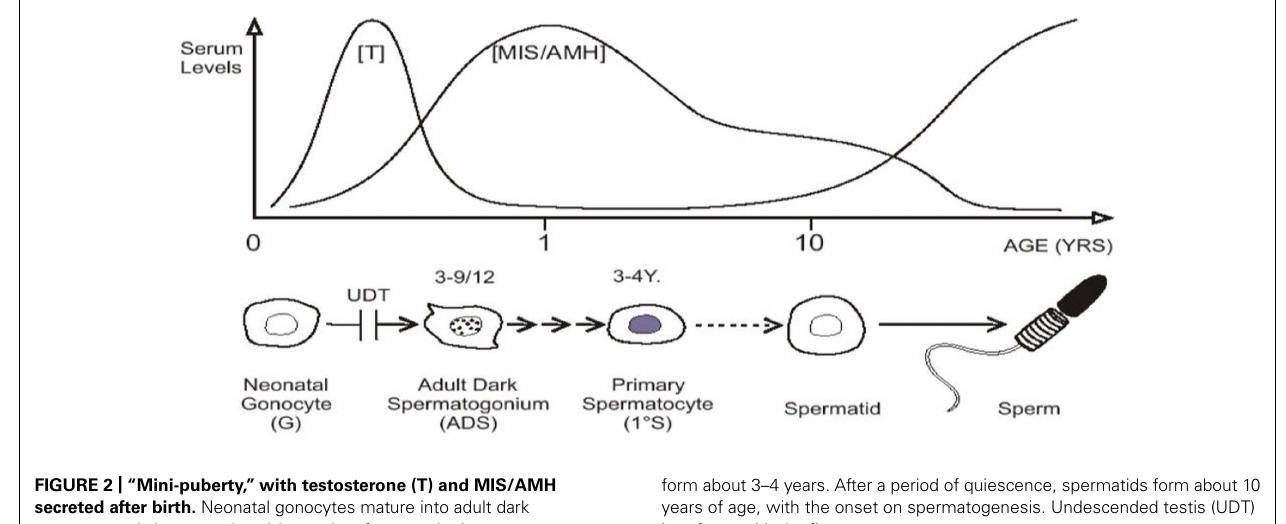
form about 3–4 years. After a period of quiescence, spermatids form about 10 years of age, with the onset on spermatogenesis. Undescended testis (UDT) interferes with the first